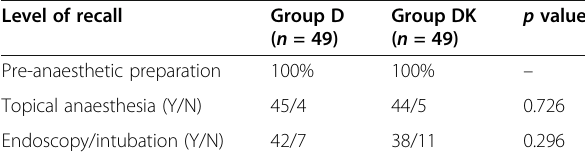
Table 3 Comparison of level recall for various events Level of recall